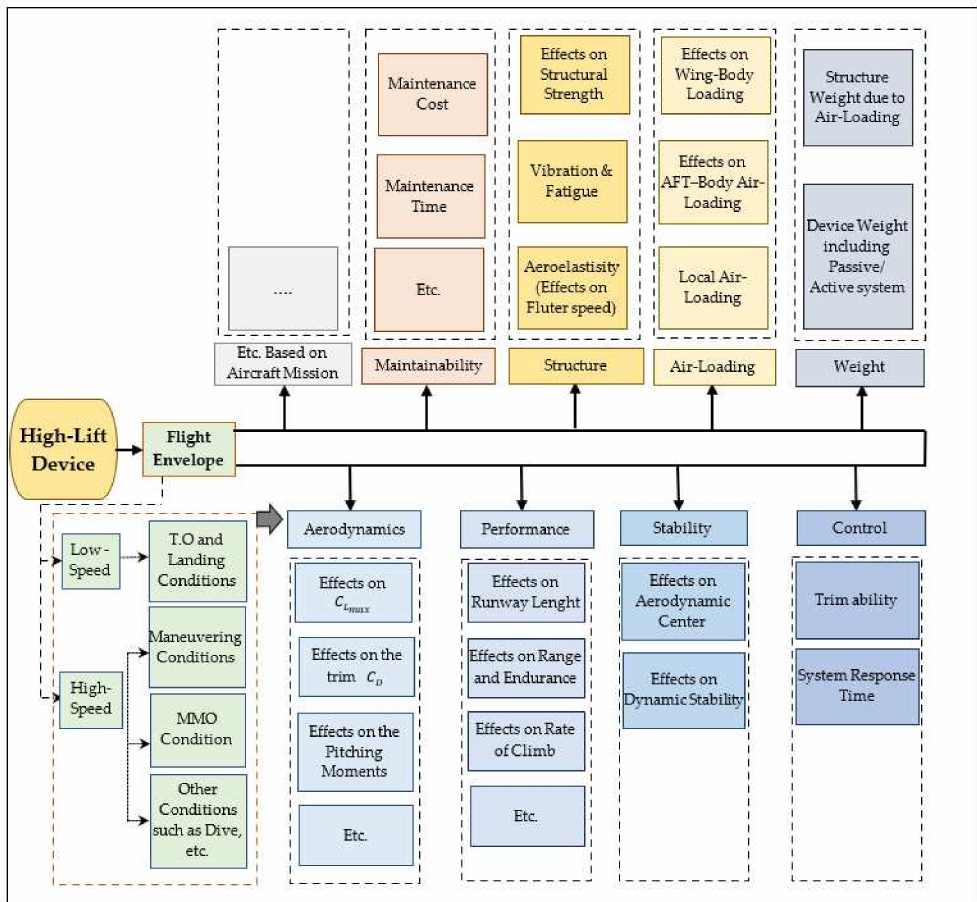
Figure 2. A typical multidisciplinary approach of a high-lift